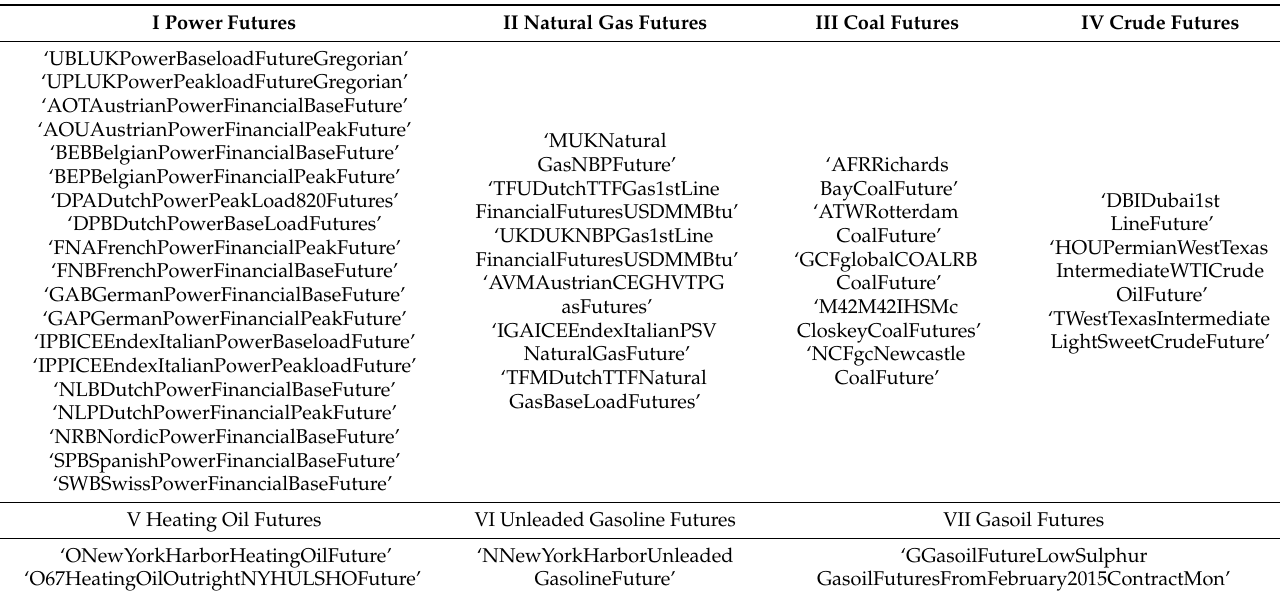
Table 1. List of indicators in product